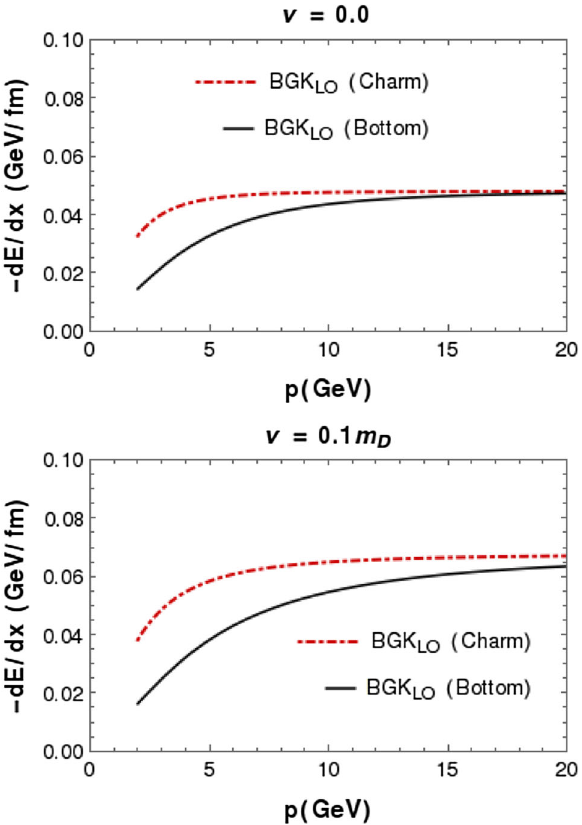
Fig. 3 Energy loss of the charm and bottom quarks at T = 2 T c and ν = 0 . 0 and 0 . 1 m D for the leading order case